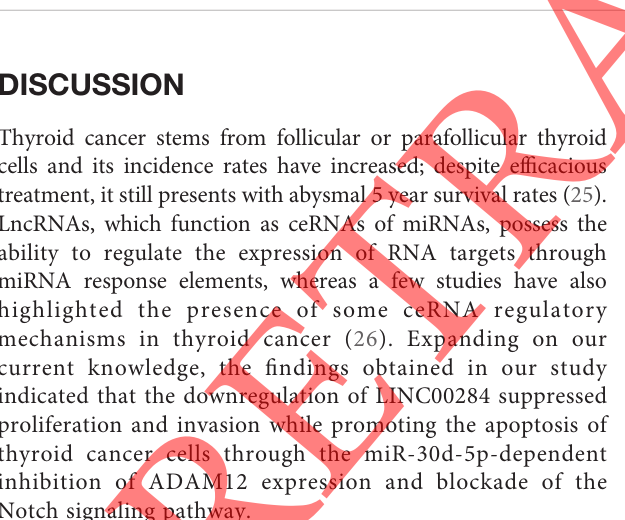
FIGURE 6 | The effect of LINC00284-mediated miR-30d-5p silencing on the tumorigenic ability of thyroid cancer cells. (A) Representative pictures of xenograft tumors in nude mice. (B) Statistical analysis of the tumor volume in nude mice. (C) Statistical analysis of the tumor weight in nude mice. (D) The expression of LINC00284, miR-30d-5p, and ADAM12 mRNA in tumor tissues was determined using RT-qPCR. (E) The expression of ADAM12 in tumor tissues measured using Western blot analysis. * p < 0.05 compared with mice injected with oe-NC-infected cancer cells, # p < 0.05 compared with mice injected with LV-NC-infected cancer cells, and & p < 0.05 compared with mice injected with oe-LINC00284+ LV-NC-infected cancer cells. Data are presented as the means ± standard deviations. Comparisons between two groups were analyzed using the unpaired t -test, comparisons among multiple groups were analyzed using one-way ANOVA followed by Tukey ’ s post hoc test, and comparisons among groups at different time points were analyzed using repeated measures ANOVA with Tukey ’ s post hoc test. The experiments were repeated three